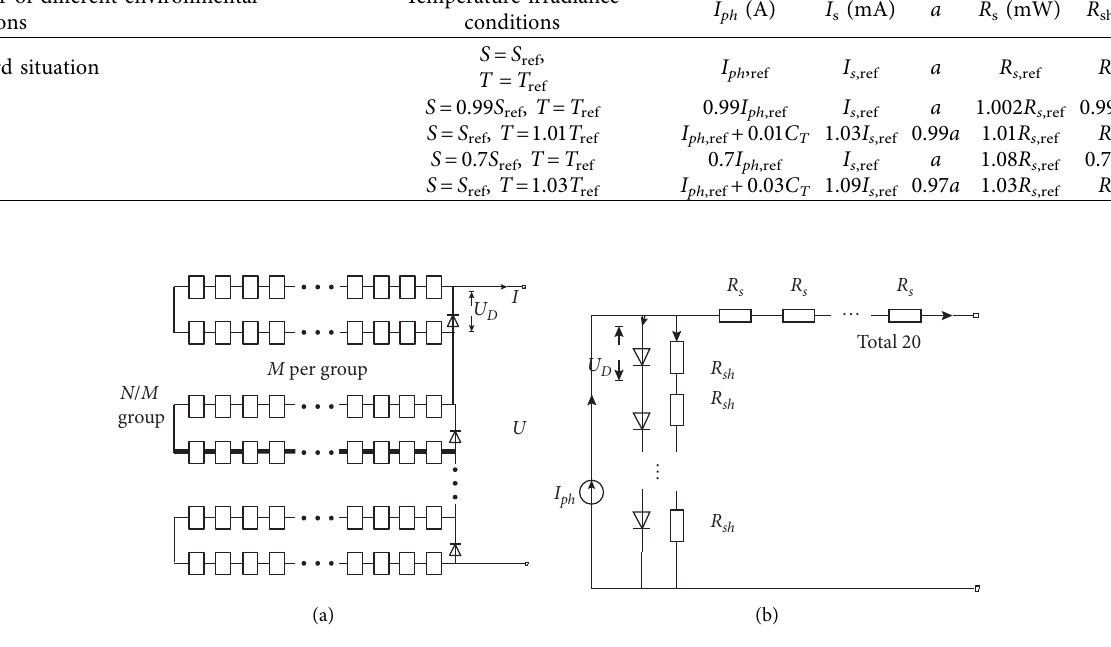
Figure 3: Schematic diagram of PV panel and equivalent circuit of a unit in PV pane. (a) Single board diagram. (b) Schematic diagram of the equivalent circuit of a series unit of solar cell veneer and component